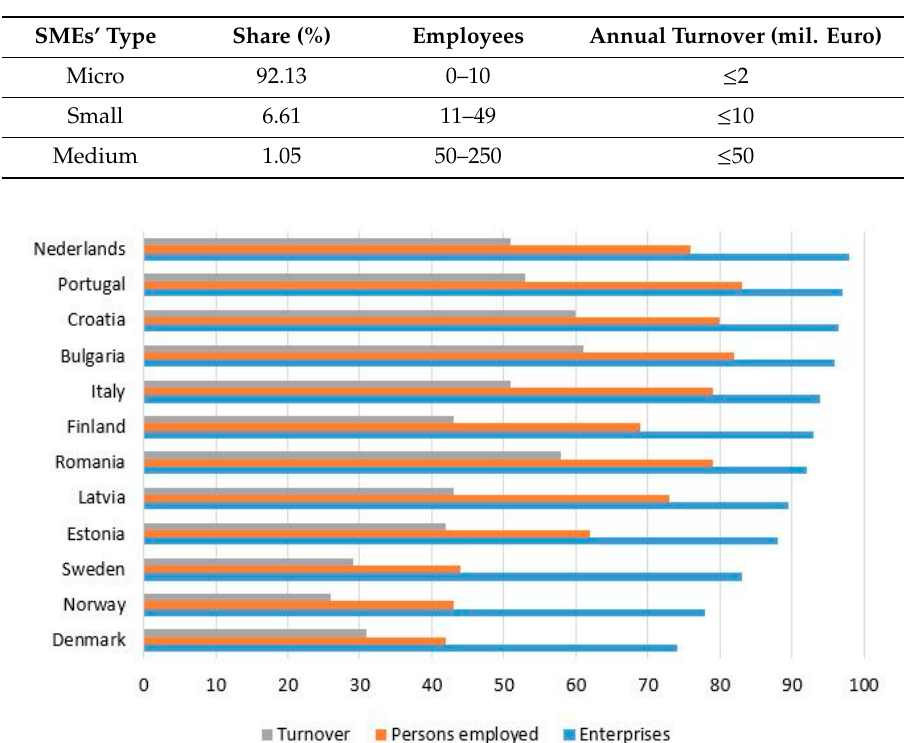
Table 1. Classification of small and medium enterprises (SMEs).